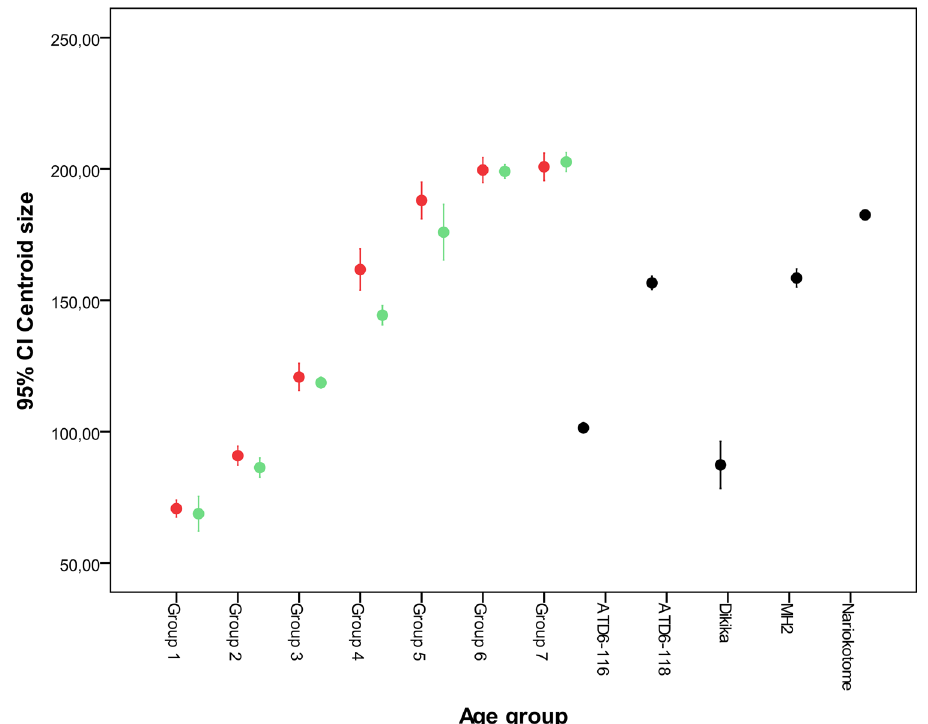
Figure 1. Centroid size analysis for the current and fossil specimens, showing 95% confidence intervals for the mean of each species and group. Numbers along the x-axis refer to the ontogenetic stage in Pan and Homo (green = Pan ; red = Homo ) and fossil scapulae are inserted. The DIK-1-1 interval is based on its right and left scapula; other fossil CI are based on particular estimates from previous analyses. DIK-1-1 is stage 2, based on its fully erupted deciduous dentition (no permanent teeth). KNM-WT 15000 is between stages 4 and 5, based on its fully erupted 2nd molar. MH2 is a small adult female, based on long bones lacking an unfused epiphysis 65 . The Gran Dolina fossils are not associated with dental remains, and so their ontogenetic stage can only be estimated by their relative size.